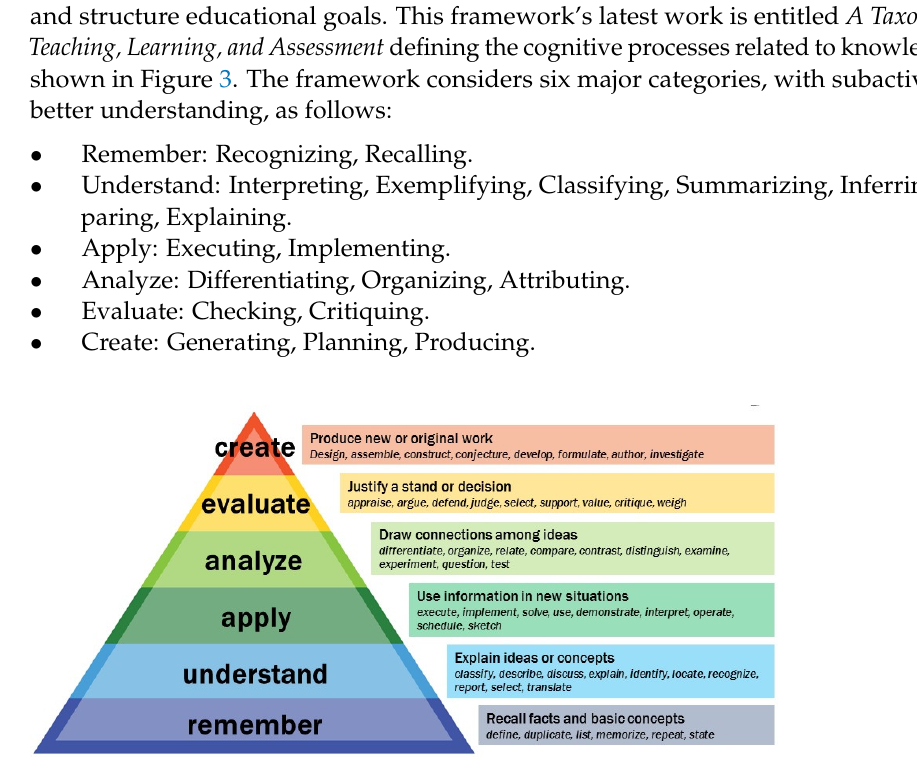
Figure 3. Bloom’s taxonomy by Vanderbilt University Center for